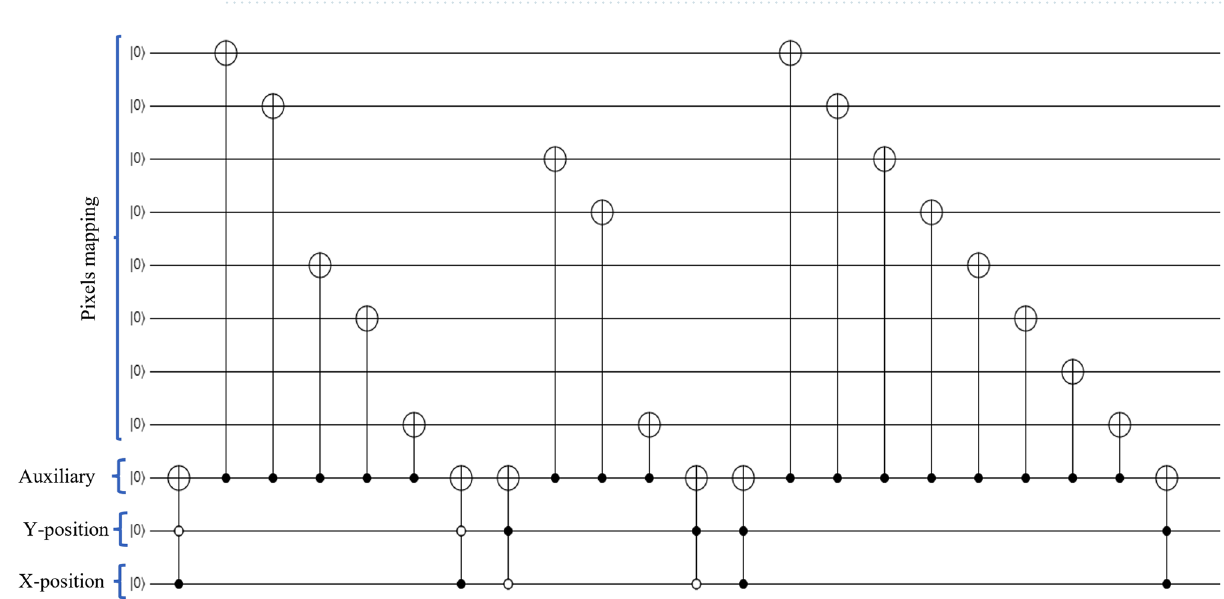
16 DCT-GQIR quantum image including state preparation. Figure 2. A 16 ×